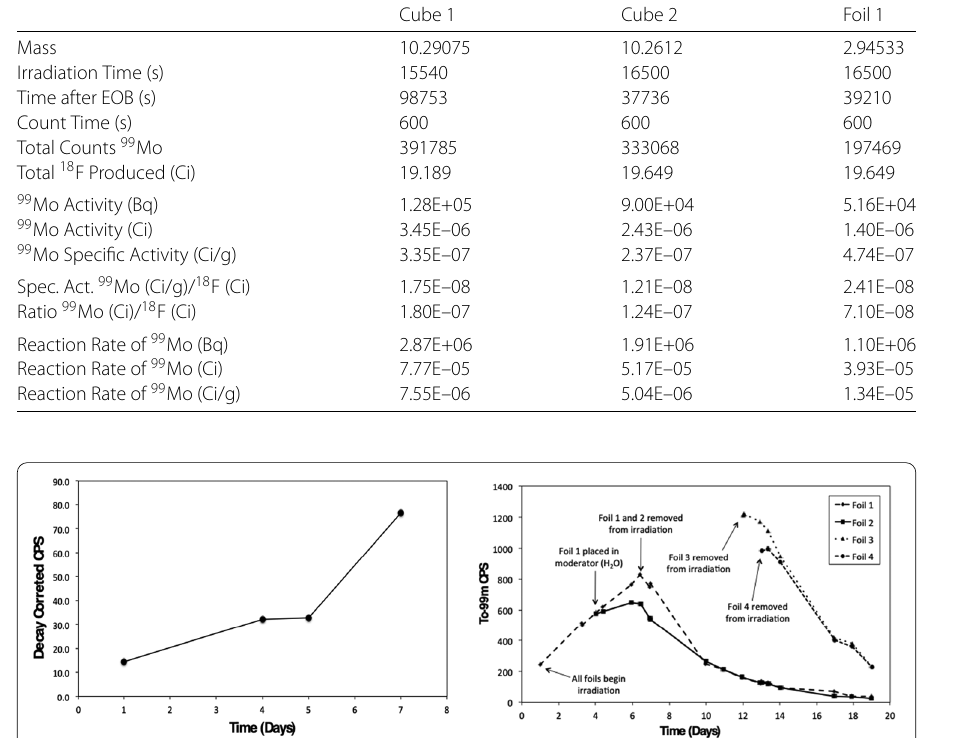
Table 2 Comparison of activities and reaction rates of 99 Mo in various Mo metal samples after one production day of 18 F in a low-energy cyclotron with neutrons generated through the 18 O( p , n ) 18 F reaction Cube 1 Cube 2 Foil 1 Mass 10.29075 10.2612 2.94533 Irradiation Time (s) 15540 16500 16500 Time after EOB (s) 98753 37736 39210 Count Time (s) 600 600